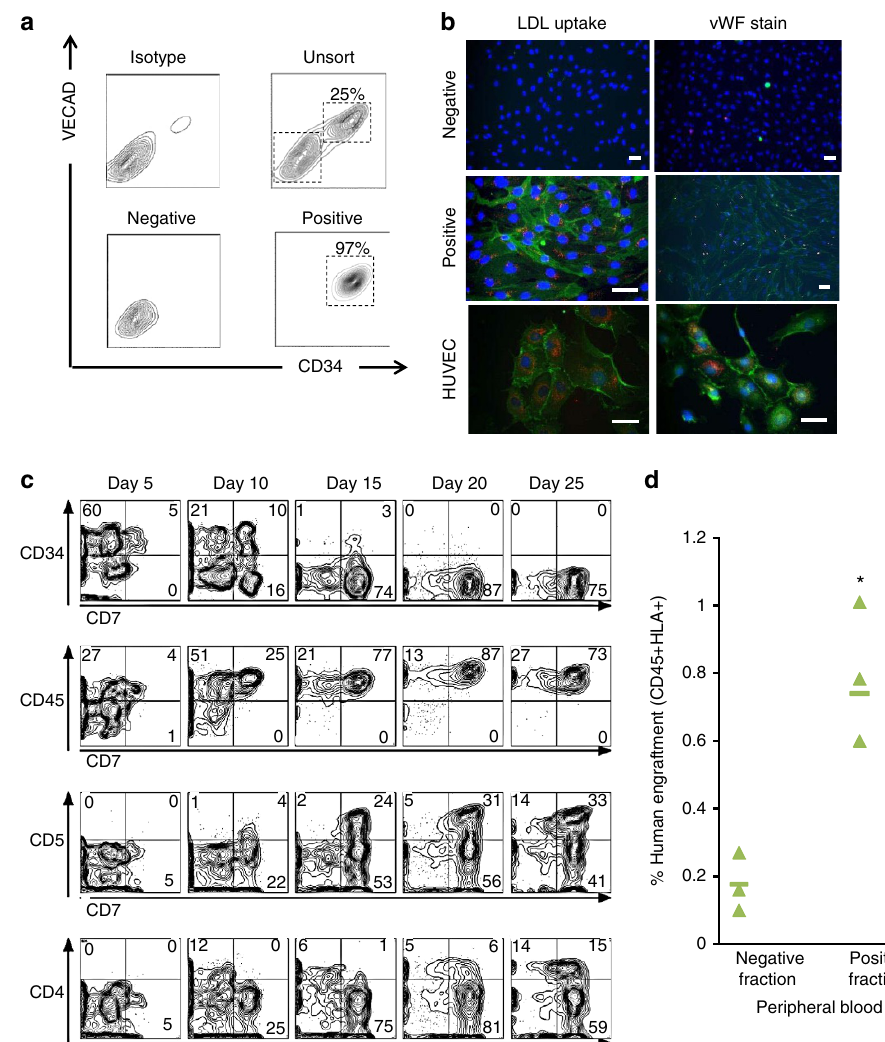
Figure 2 | Day 8 hPSC-derived cells display HE characteristics and possess definitive blood potential. ( a ) Representative day 8 flow cytometry plots showing isotype, unsorted, sorted negative fraction and sorted positive fractions. ( b ) Immunocytochemistry of day 8 CD34/VECAD fractions show DiI-Ac-LDL (red speckled) and vWF production (punctate red) only in positive cell fractions. Human umbilical vein endothelial cells (HUVECs) were used as positive controls. Positive fractions and HUVECs are concomitantly stained with VECAD (green—VECAD) and Hoechst (blue—Hoechst). Scale bar, 50 m m. ( c ) Kinetics of T-cell development of day 8 aggregate-derived hPSCs, enriched via magnetic-activated cell sorting, shows downregulation of CD34 expression and upregulation of CD45, CD7 and CD5 expression at indicated time points of co-culture with OP9-DL4 stroma, n ¼ 3. Cord blood-derived cells were used as positive controls for stromal culture (not shown). ( d ) Phenotypic analysis for detection of human CD45 þ HLA þ expression in peripheral blood of NSG recipients 10 weeks post injection, n ¼ 3. Treatments displaying asterisks are significantly different from other groups ( P r 0.05, Student’s t -test). See also Supplementary Figs